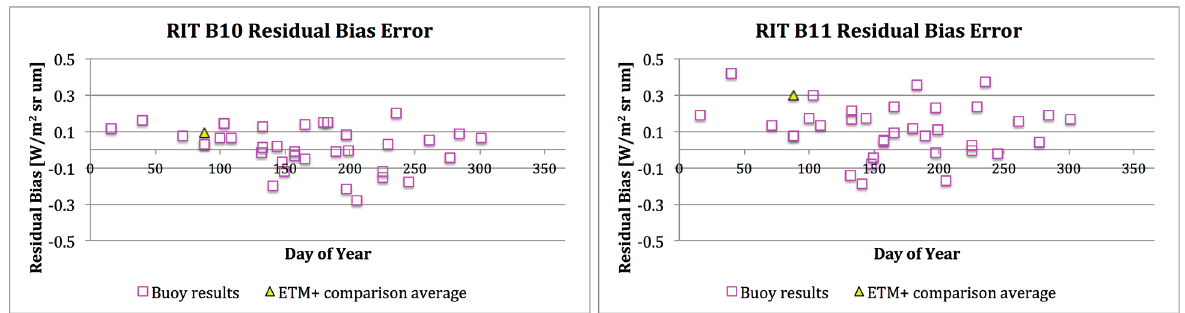
Figure 12. Seasonal effect of the residual bias error for the RIT data, including the average error for the ETM+ comparison. Data are plotted versus day of year but the seasonal effect is not as apparent in the RIT data as in the JPL data (Figure 11). The ETM+ comparison data point sits within the residual errors of the buoy data.